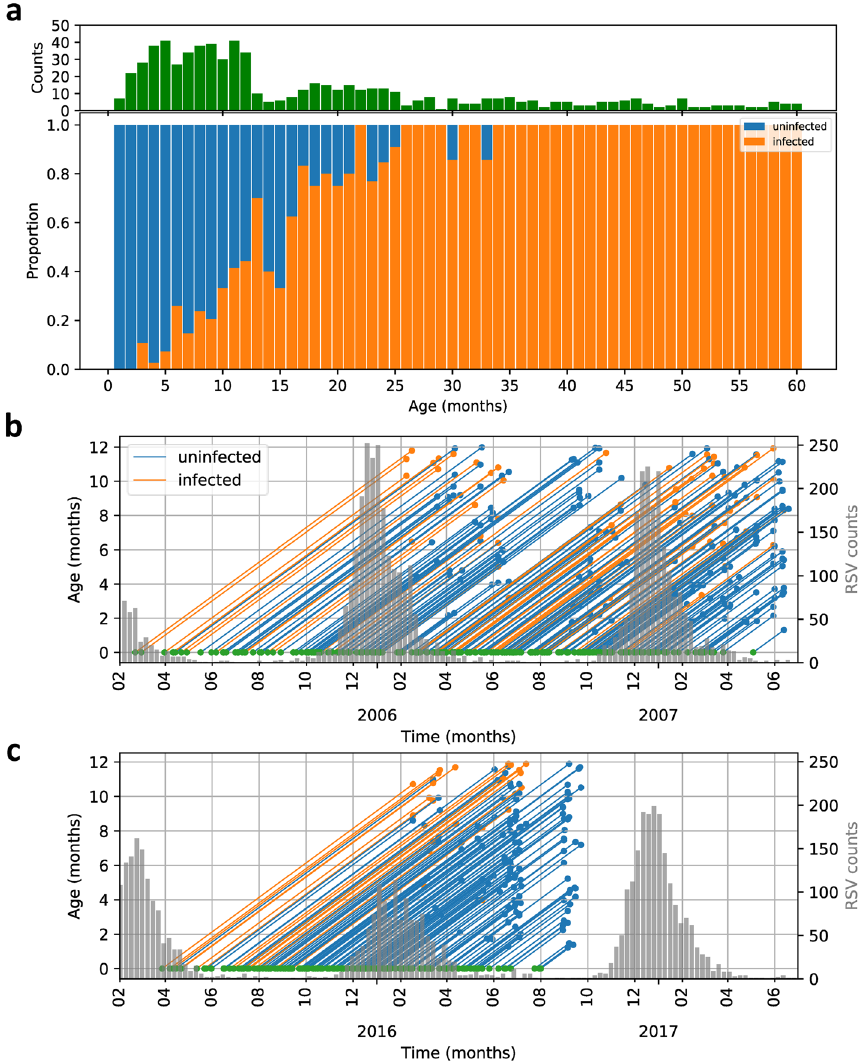
Figure 2. Dependence of infection status on age and date of birth within the year. ( A ) Bar chart (top) and proportional bar chart (bottom) showing the total number of samples (green), and fractions that are classified as infected (orange) and uninfected (blue). ( B , C ) Lexis diagrams of infection status of infants under 12 months of age in the 2006/2007 and 2016/2017 cohorts (see Supplement Figure 3 for full age range). Left-hand y-axes correspond to individual life histories. Individuals are born at the green dots, and sampled at the orange (infected) and blue (uninfected) dots, respectively. Right-hand Y-axes correspond to the histograms of the weekly number of positive RSV tests in hospitals in the Netherlands, representing the RSV